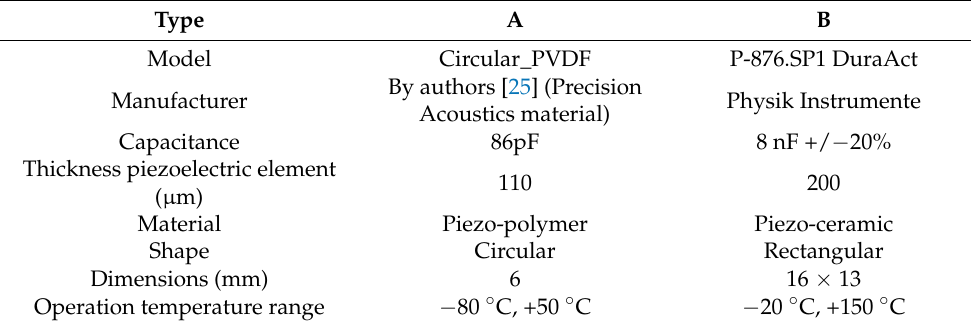
Table 2. Peak voltages recorded with PI.876.SP1 and PVDF the sensors with varying test mass m and free-fall height h.